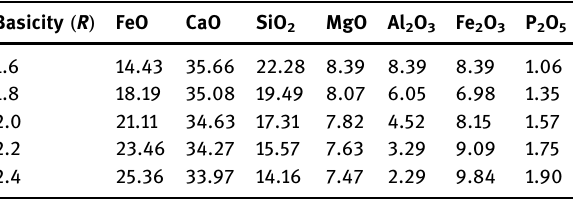
Table 6: Main chemical composition of mixed slag wt/% Basicity ( R ) FeO